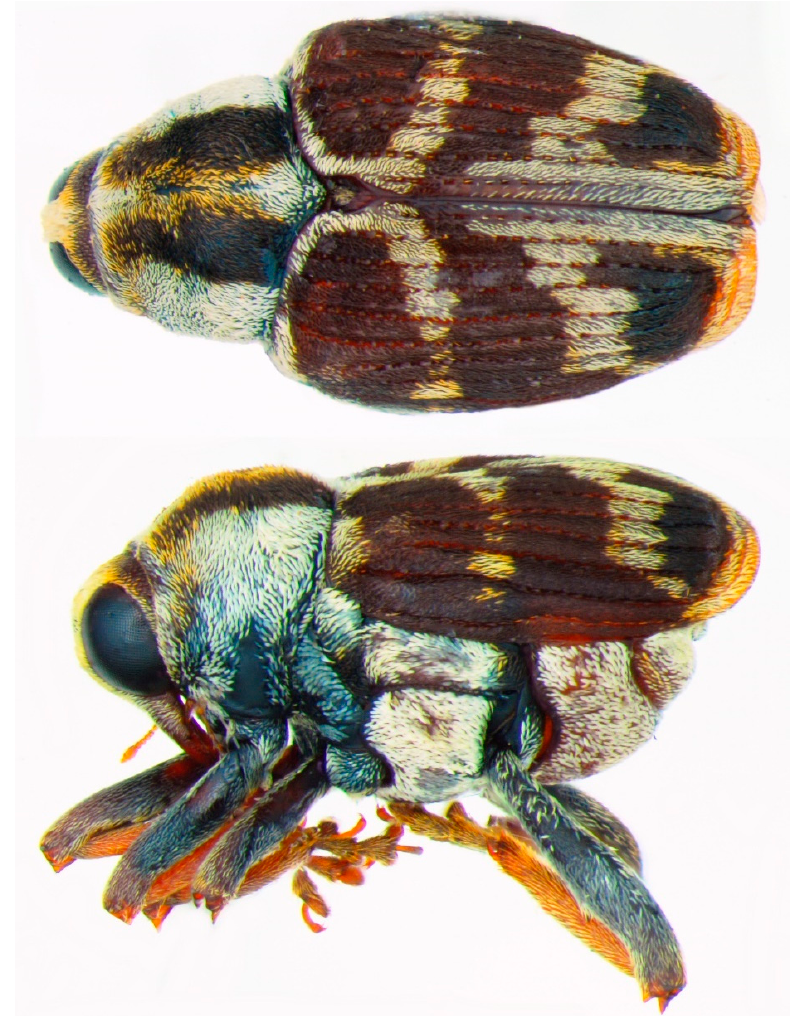
Figure 5. Philenis costaricensis , dorsal and lateral habitus.